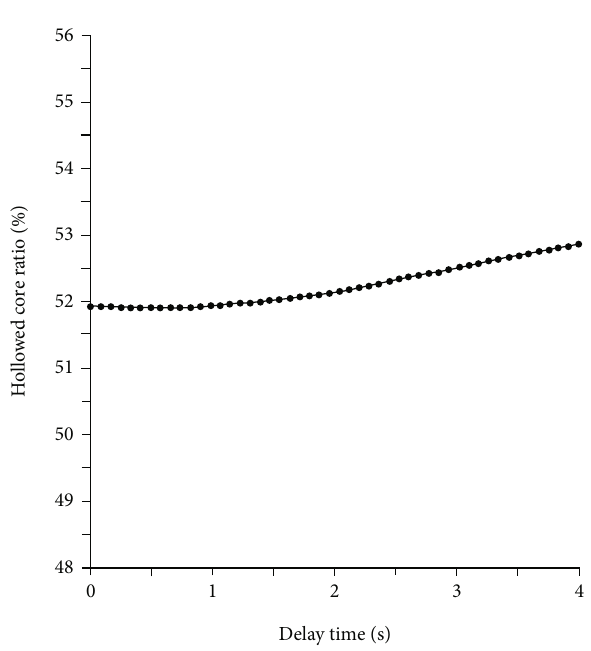
Figure 9: E ff ect of water pressure on hollowed core ratio.